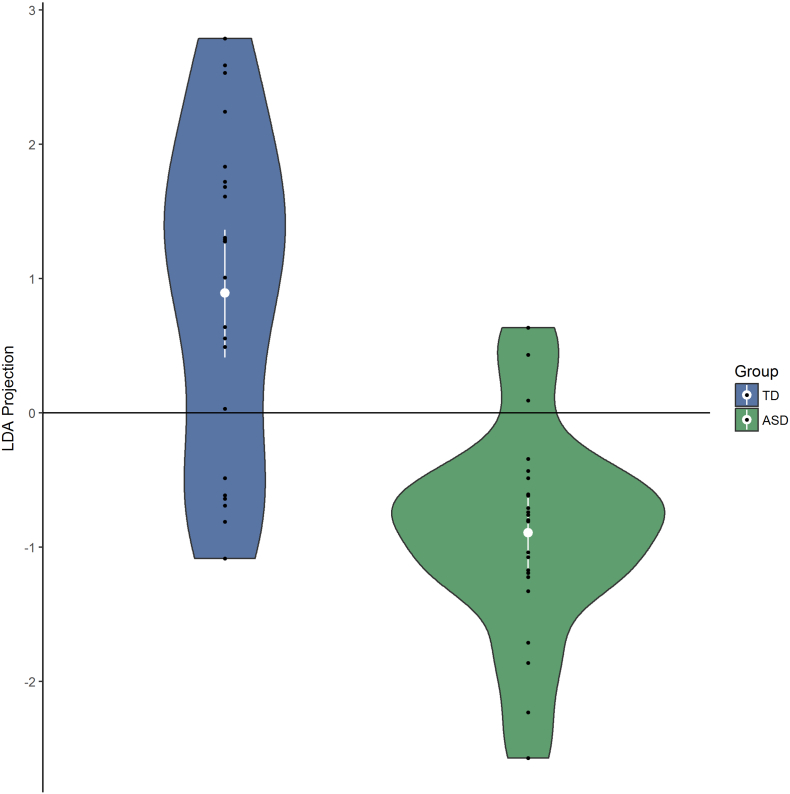
Violin plot of the ten-dimensional data of the relevant harmonics of the individual face discrimination response, projected along the LDA projection vector. The LDA was fitted to the full dataset and illustrates the separability of the groups. The horizontal line represents the decision boundary of the LDA classifier.